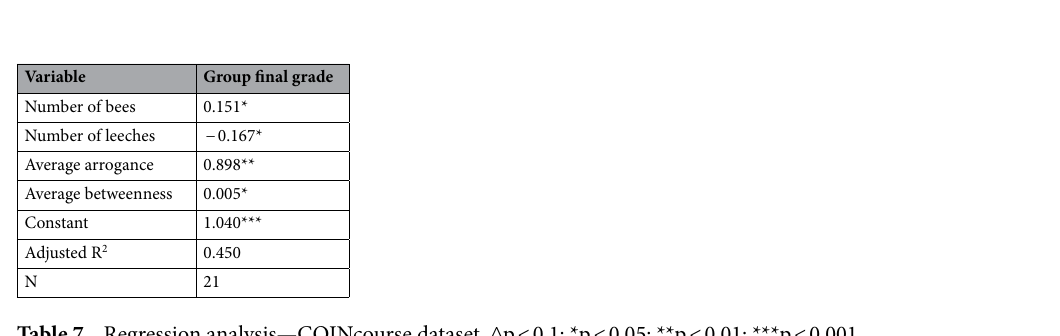
Table 7. Regression analysis—COINcourse dataset. ^p < 0.1; *p < 0.05; **p < 0.01; ***p <